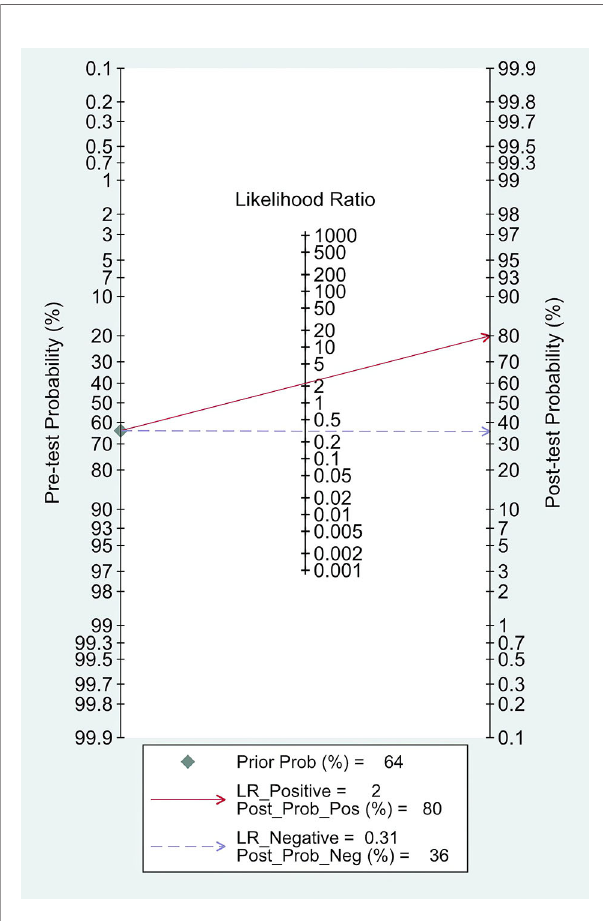
FIGURE 9 | Fagan ’ s nomogram for likelihood ratios.